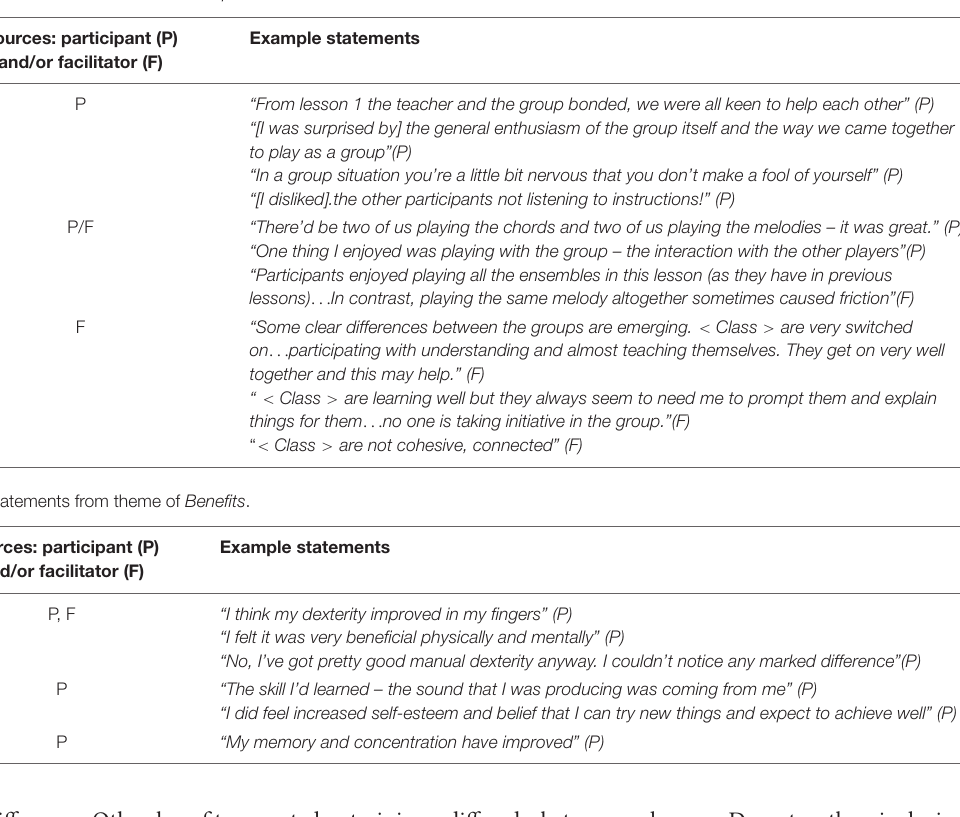
TABLE 5 | Sub-themes and example statements from theme of Groups .